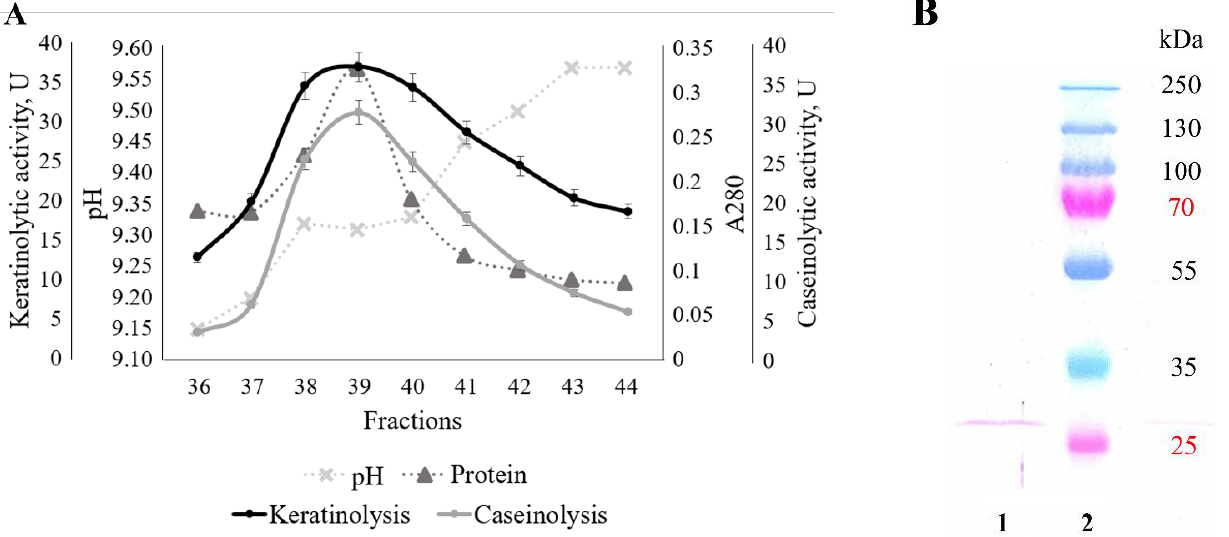
Figure 6. Isoelectric focusing of extracellular proteins synthesized by Aspergillus clavatus VKPM F-1593 in the ampholines’ pH range from 8.0 to 10.5: ( A ) fraction profiles of pH, protein amount, keratinolytic and caseinolytic activity; ( B ) SDS-PAGE of extracellular keratinase (fraction 39 (1); pre-stained protein ladder (2)).